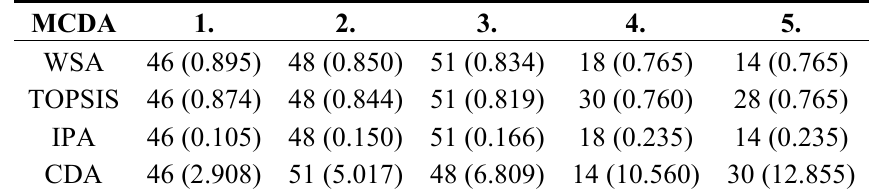
Table 11. Final MCDA scores for environmental evaluation of all floor structure